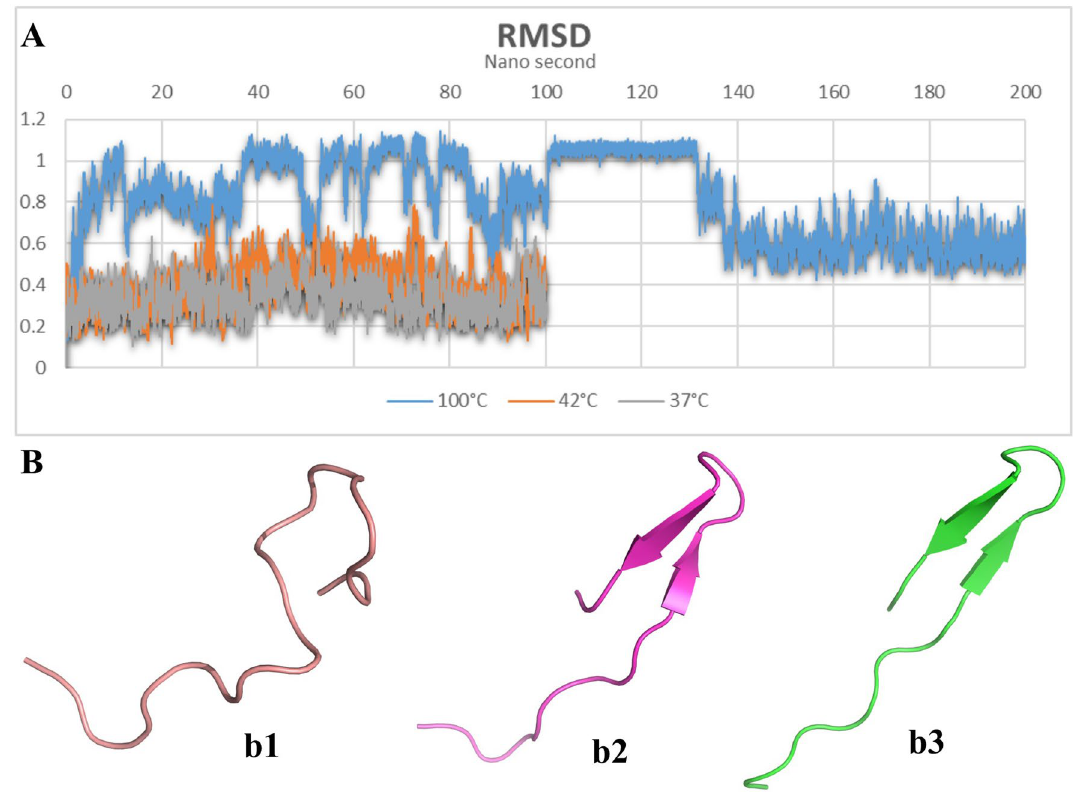
Figure 1. ( A ) The root-mean-square deviation (RMSD) of thanatin α-carbons (nm) versus time (ns). ( B ) The tertiary structure of thanatin in (b1) water boiling temperature at sea level, (b2) avian normal body temperature, (b2) dairy cattle normal body